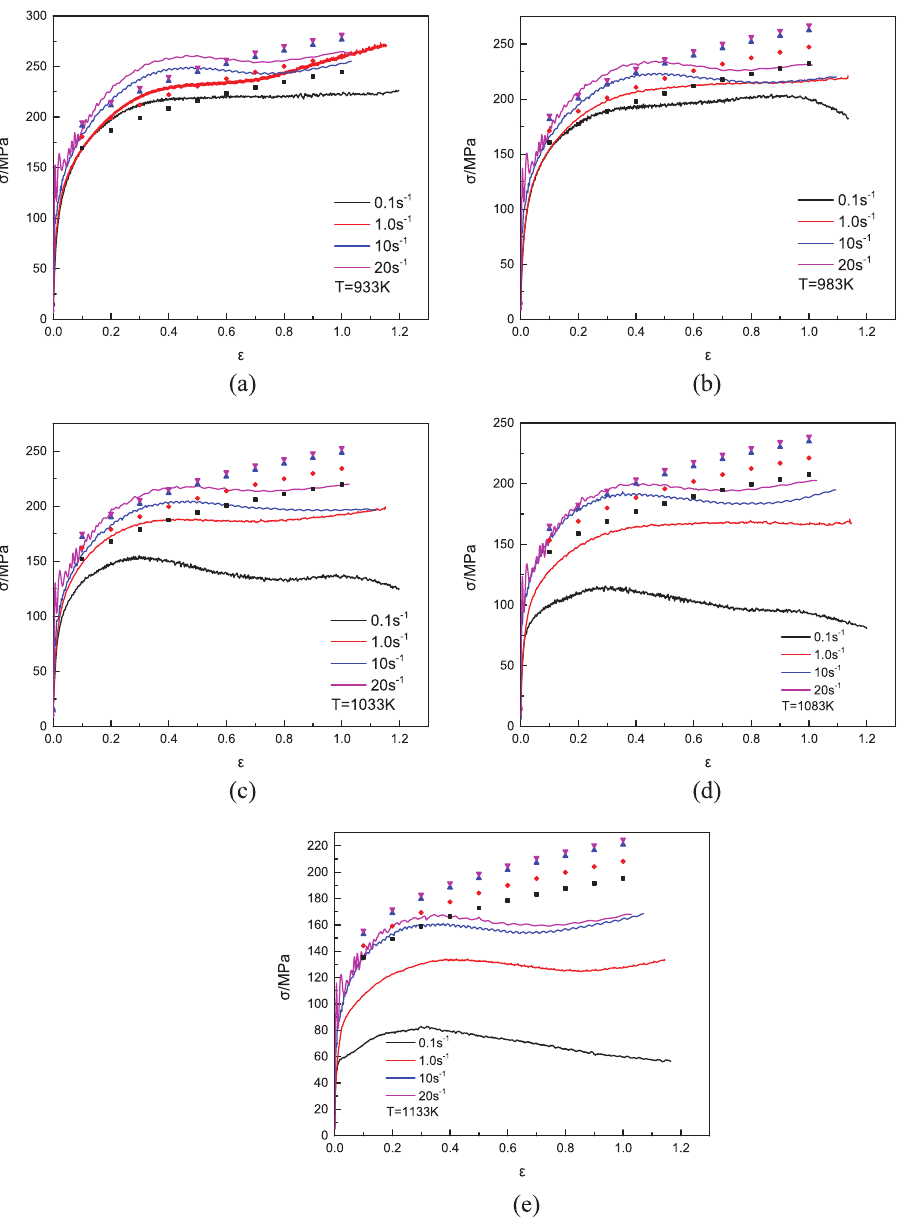
Figure 6: Comparison between experimental and predicted flow stress using Johnson – Cook model at the temperatures of (a) 933 K, (b) 983 K, (c) 1,033 K, (d) 1,083 K, (e) 1,133